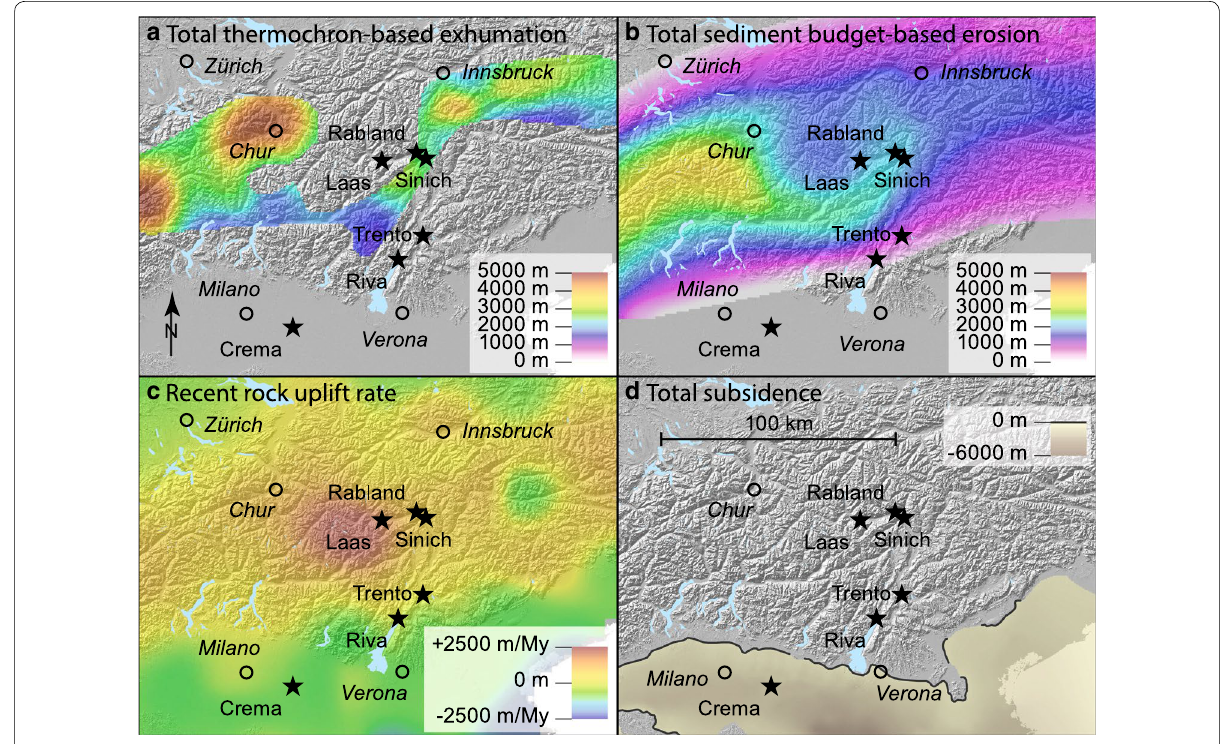
Fig. 4 Estimates of accumulated uplift from Late Messinian until present. a Thermochron-based model of Fox et al. (2016), note that the data quality is strongly variable, we only show the best resolved areas. b Sediment budget based model of Kuhlemann (2007). a and b use the same colour code for comparison. The thermochron based exhumation is larger than the estimations based on sediment budgets. c Present day rock uplift rates (Sternai et al. 2019). d Post-Messinian subsidence in the Po Plain inferred by interpretation of seismic reflection data shown in brown (Bigi et al. 1992), the black line indicates zero vertical motion since Messinian. The stars mark the locations of the cross sections in Fig.